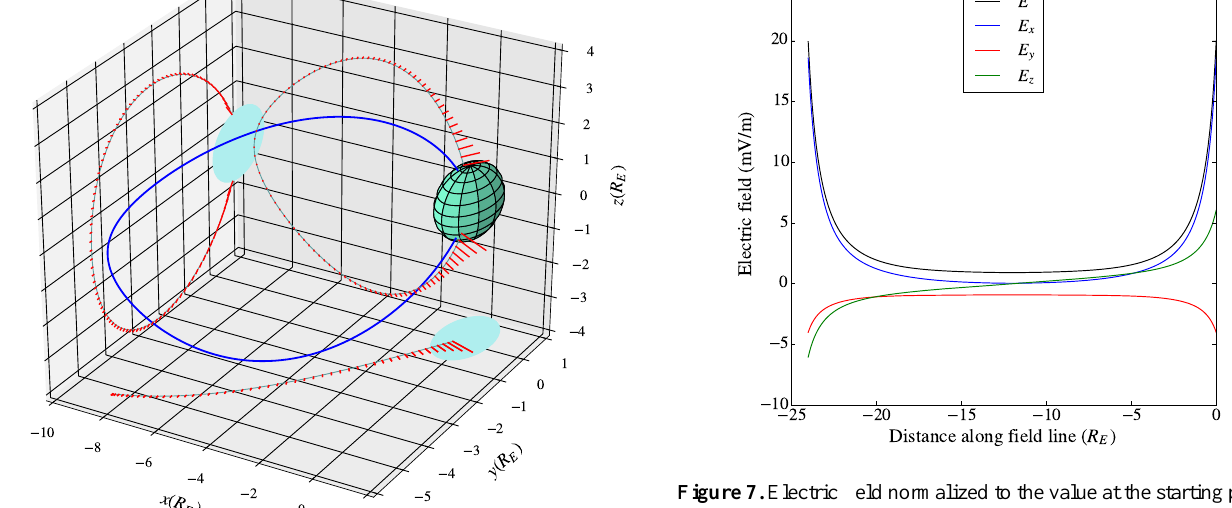
Figure 7. Electric field normalized to the value at the starting point, for the field line traced and electric field mapped in Fig.